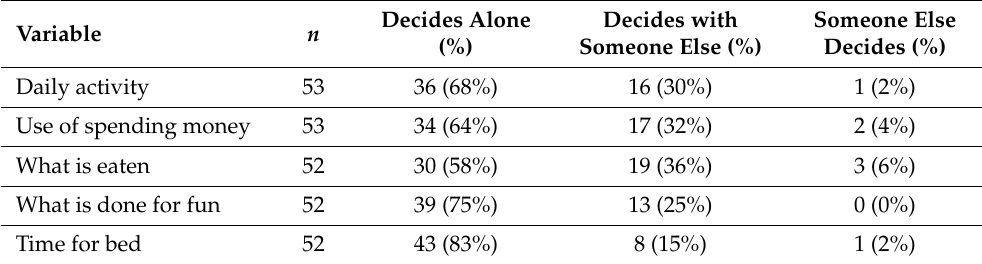
Table 2. Participant functional capabilities.